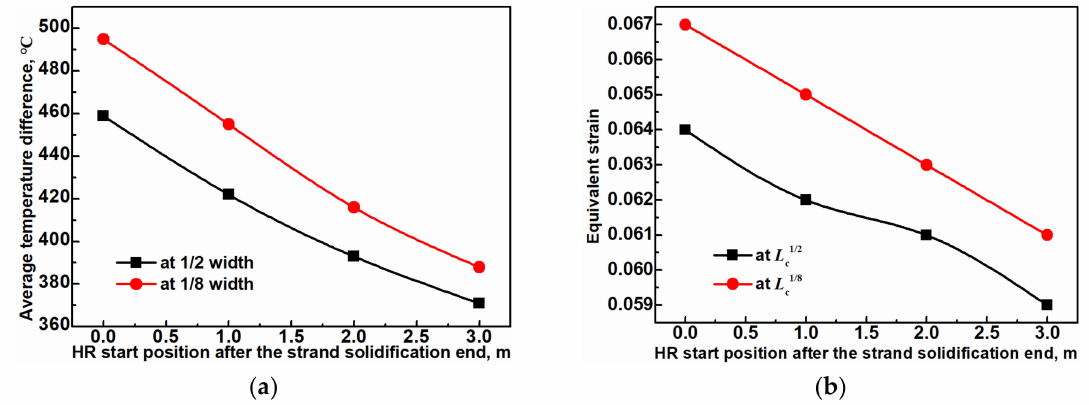
Figure 15. ( a ) The average temperature difference at 1/8 width and 1/2 width within the HR segment and ( b ) the equivalent strain at the slab center of 1/8 width ( L c1/8 ) and 1/2 width ( L c1/2 ) after 6% HR deformation implemented at different strand